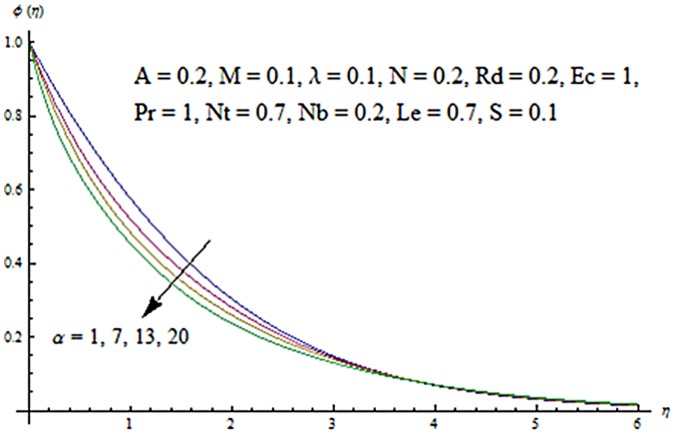
Influence of α on ϕ.